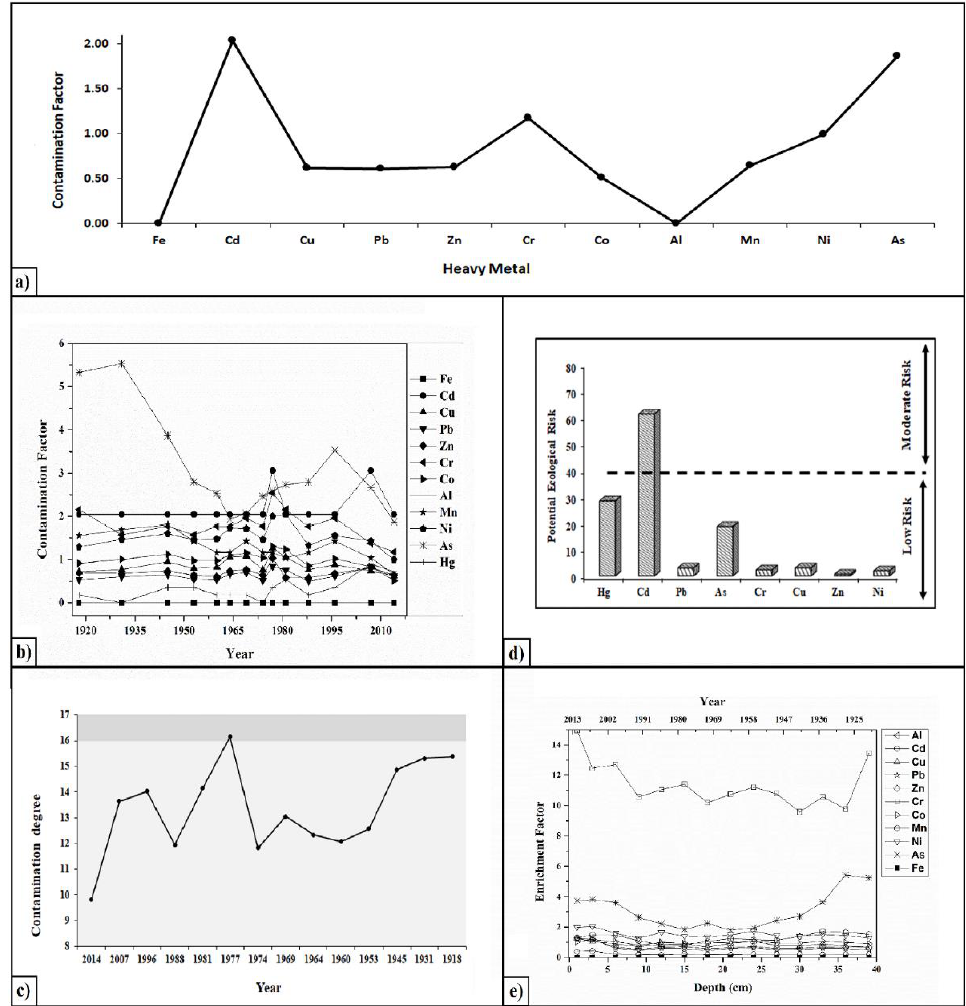
Figure 5. Contamination factor in surface sediment samples ( a ), temporal fluctuation of the contam- ination factor ( b ) and temporal variation of contamination degree between 1918–2014 (bright grey— moderate degree of contamination; dark grey—considerable degree of contamination) ( c ), potential ecological risk of investigated elements ( d ), enrichment factor of investigated heavy metals ( e ).